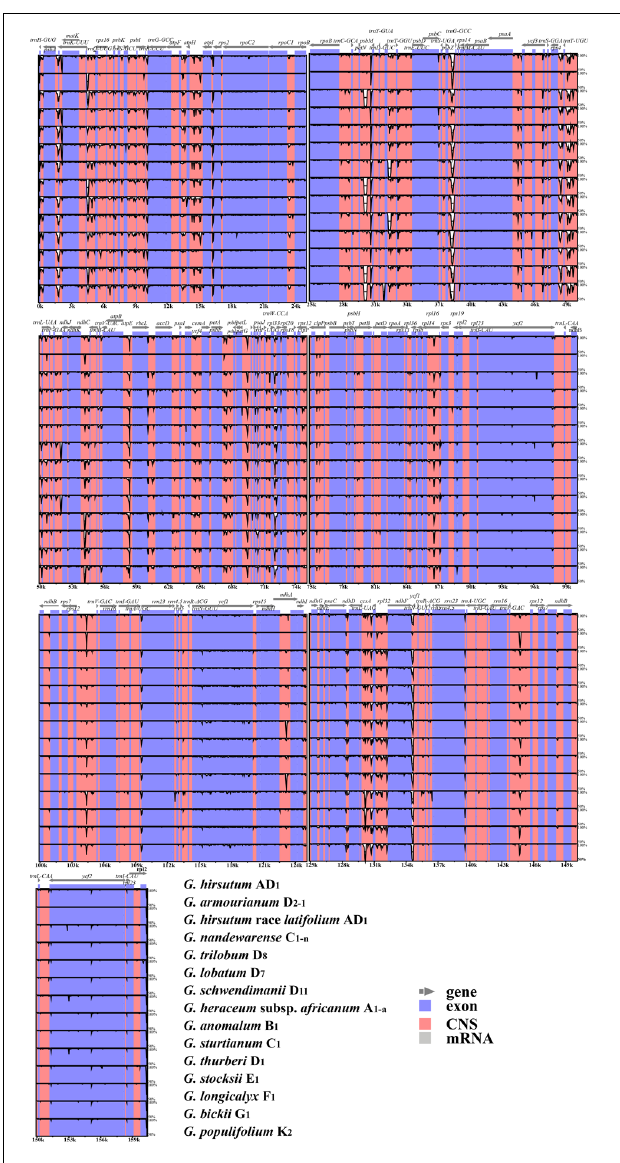
FIGURE 3 | Sequence identity plots based on 15 Gossypium chloroplast genomes, with Gossypium hirsutum as a reference. Sequences of chloroplast genomes were aligned and compared using the mVISTA program. Annotated genes are displayed along the top. The vertical scale indicates the percentage identity ranging from 50 to 100%. Genome regions are color coded as exon, conserved non-coding sequences (CNS), and